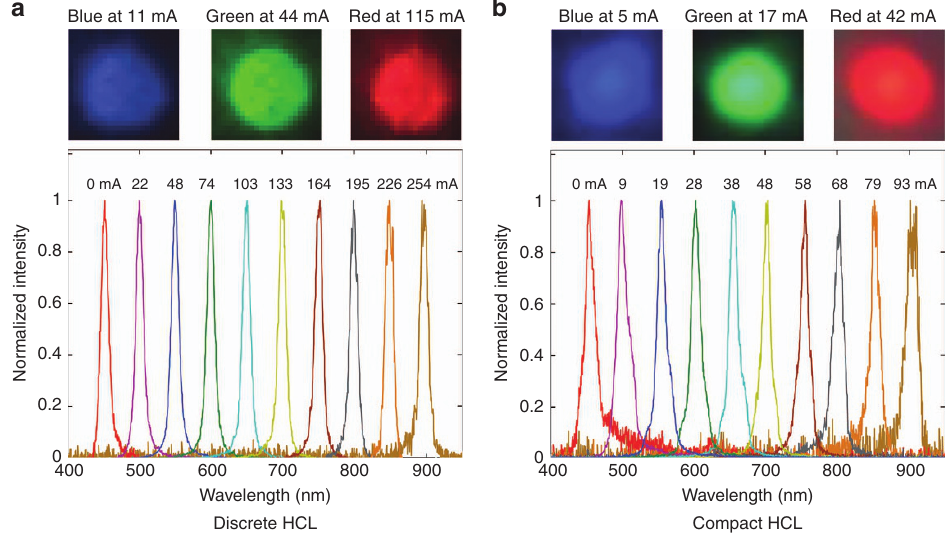
Figure 7 Chromatic confocal measurement results for the discrete HCL ( a ) and the compact HCL ( b ). The measurement setup is shown in Figure 2a where the white light point source is used. Upper parts are the images of the three colors (red, green and blue) dispersed from the white light source, focused on the pinhole and seen by a camera. The lower diagrams are the normalized spectral transmissions through the hyperchromatic lens at various actuating currents, detected by a